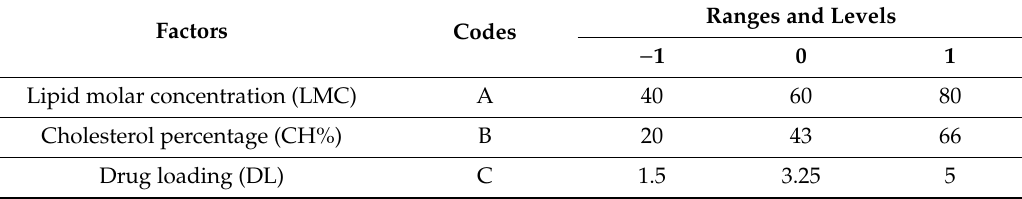
Table 1. Selected factors for the optimization of propolis liposomes (PP-Lip)